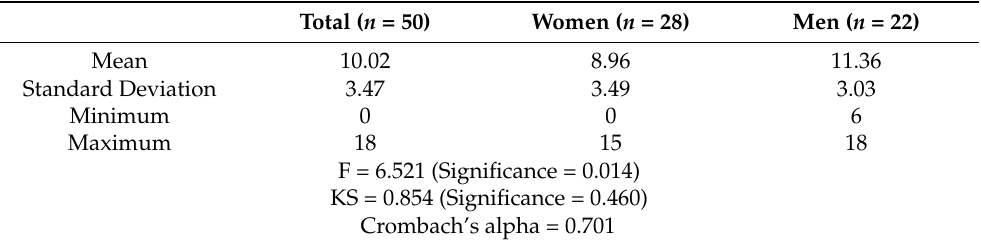
Table 1. Mean, standard deviations, and maximum and minimum scores of the 18-item version of the test.